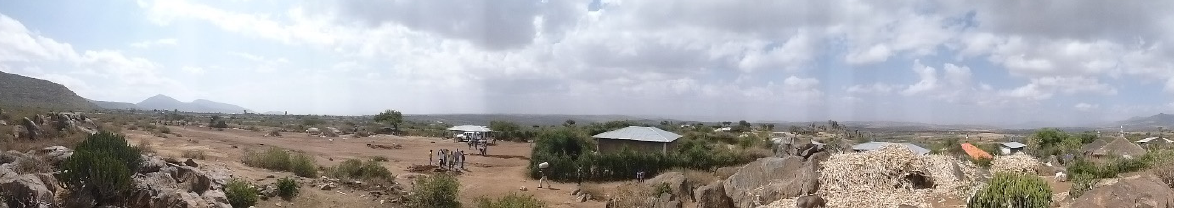
Figure 1. The rural settlement in Handew. Reprint with permission, rurerg.net (accessed on 24 May 2022).